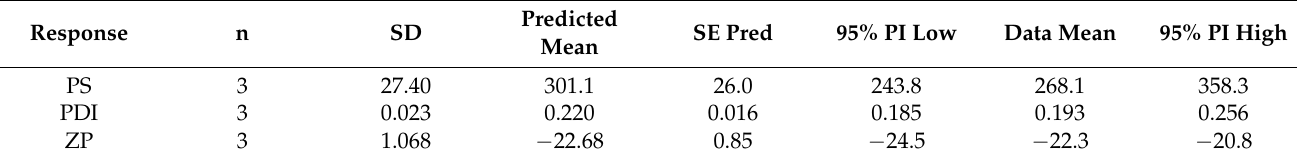
Table 5. Validation of the experimental design model (SL/LO = 3, Plain-NLC (LCT) ).